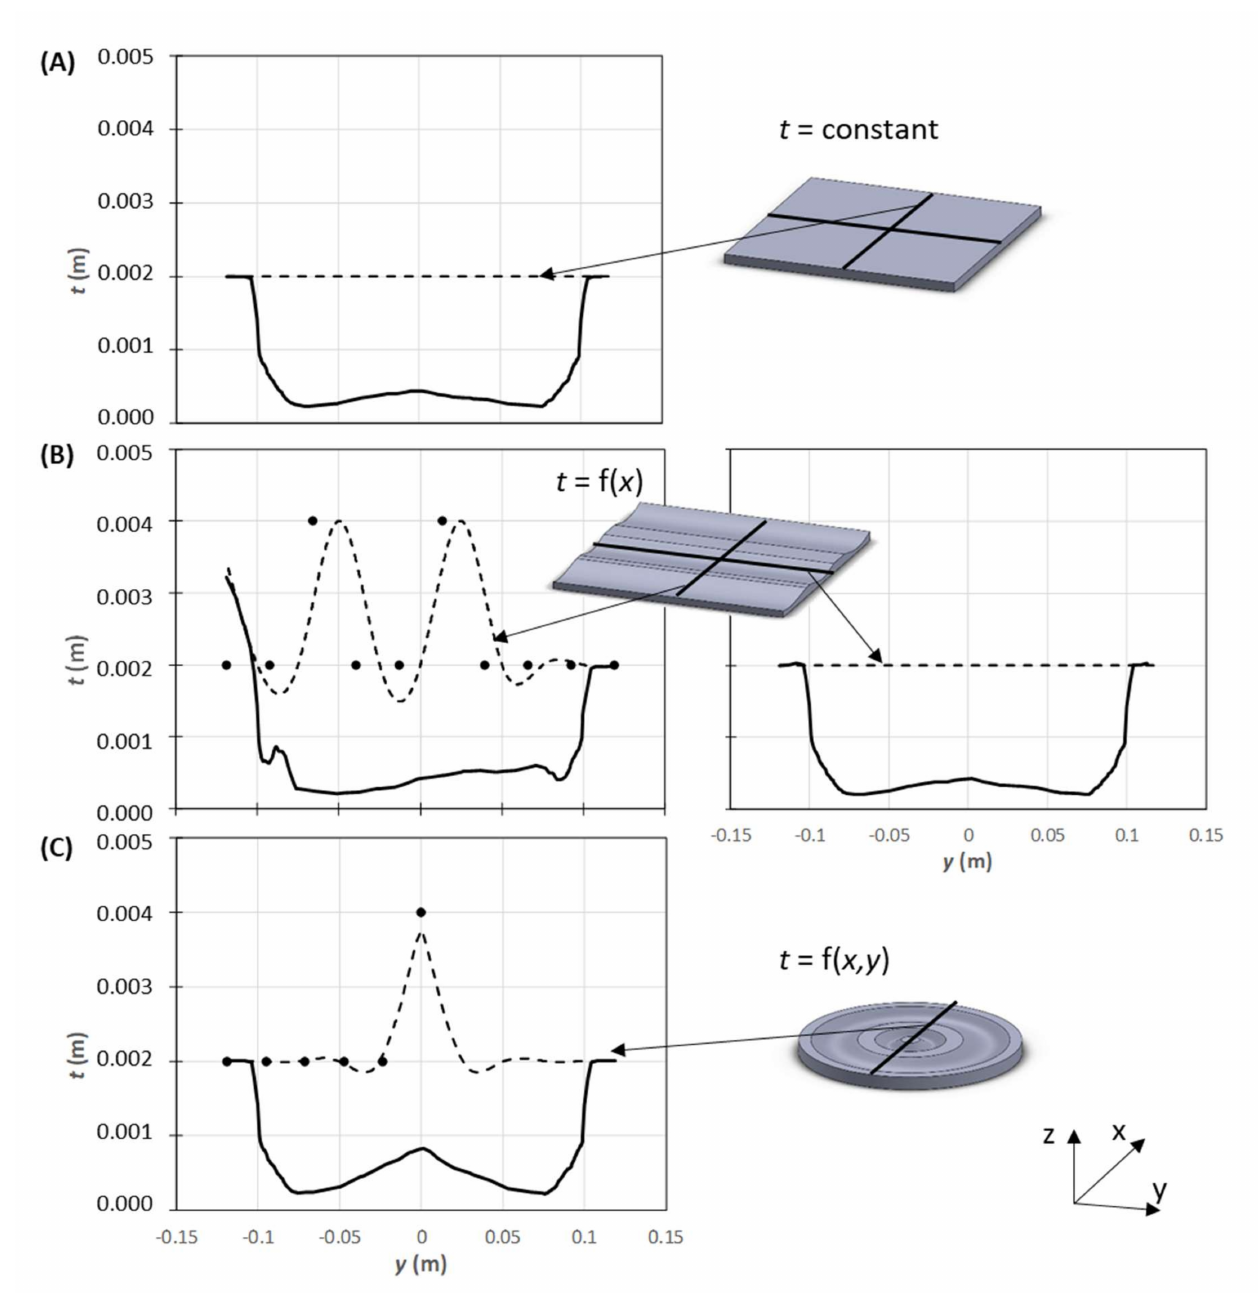
Figure 5. Multi-objective optimization of the initial sheet thickness profile that will induce a uniform thickness distribution in the part and minimize the quantity of material used: ( A ) sheet with uniform thickness; ( B ) sheet with thickness varying transversally to the extrusion direction with a spline shape; and ( C ) sheet with concentric thickness variation with spline shape. The dashed lines represent the sheet profile generated from the points in ( B , C ), the continuous line represents the thickness profile of the part (adapted from